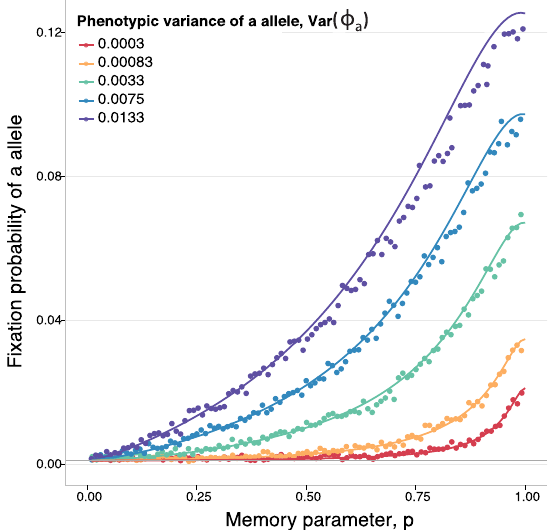
Figure 2. Fixation probability of a phenotypically variable allele in a constant environment. The phenotype of the A allele is fixed at Φ A = δ 0.8 . The a allele only has access to two equiprobable discrete phenotypes, one with higher fitness than the A allele, and one with lower fitness, with mean also equal to 0.8. Colors represent different phenotypic variances, with Var ( Φ a ) presented in the legend. The dots show the fixation probability